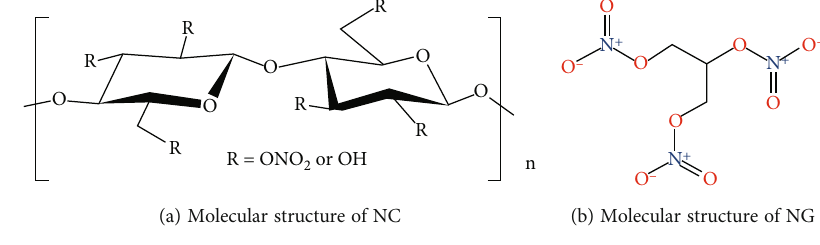
Figure 6: Molecular structures of NG and NC. Table 3: Input parameters of the binder.